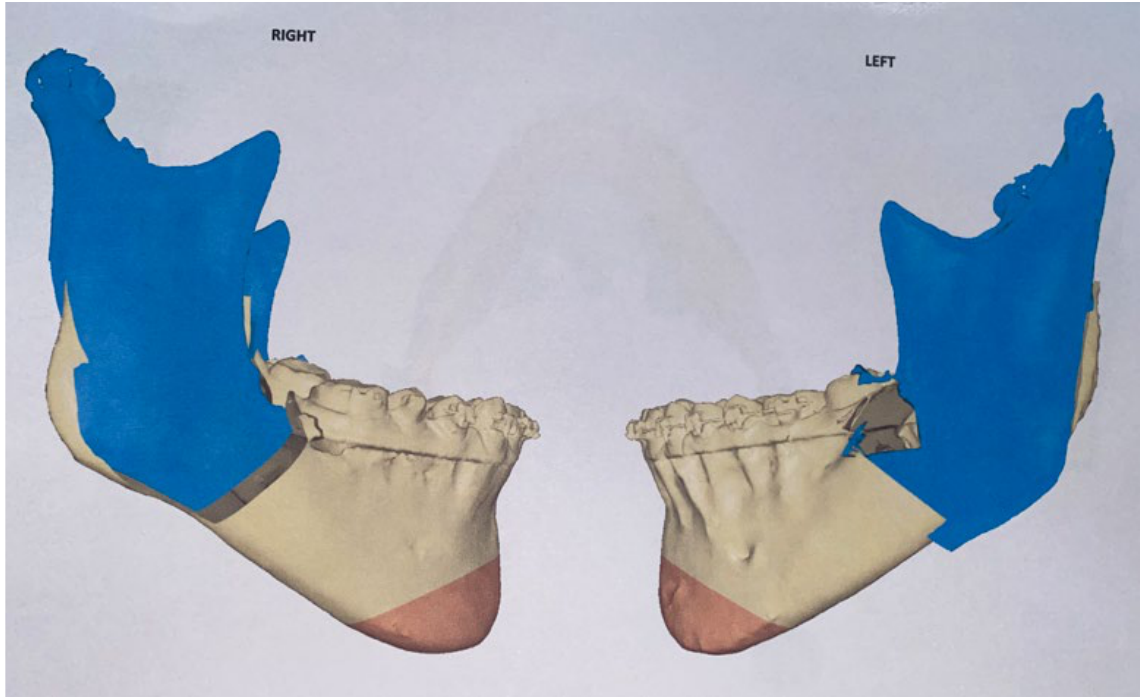
Figure 11. Virtual planning for BSSO approach.